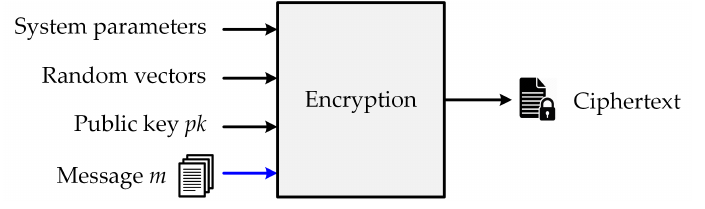
Figure 2. Encryption process of a public-key